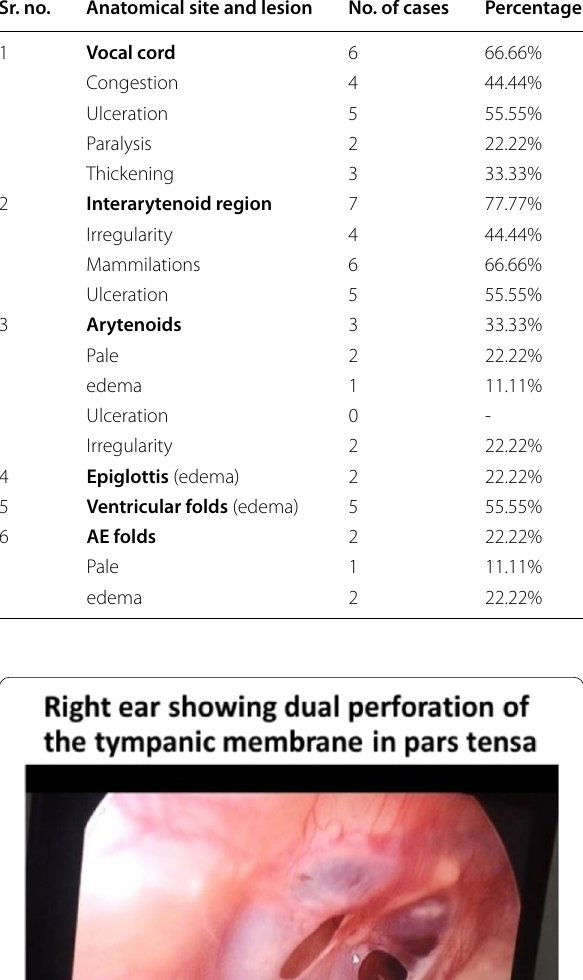
Table 5 Findings in the patients with tuberculosis of the larynx Sr.